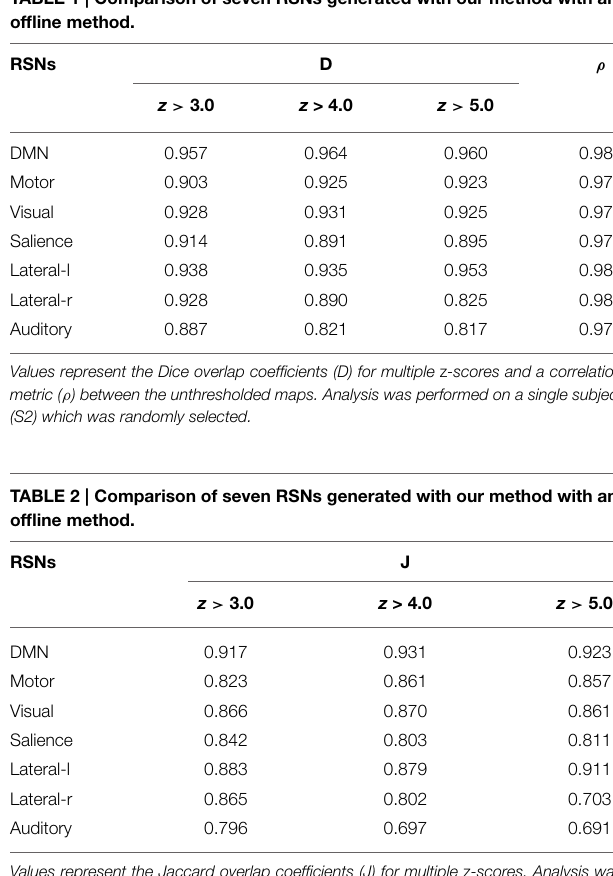
TABLE 1 | Comparison of seven RSNs generated with our method with an offline method. RSNs D